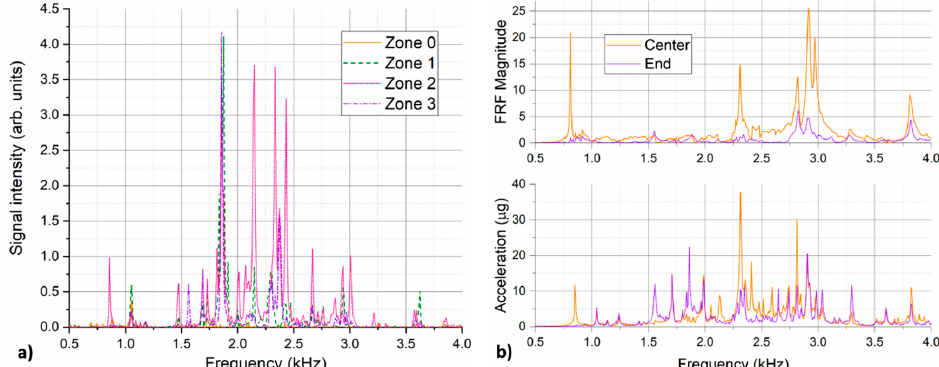
Figure 7. ( a ) Overall DAS signal spectra in different pipe zones for 1 mm leak at 25 bars; ( b ) Comparison of accelerometer signals recorded in the pipe zone 2 for 1 mm leak at 25 bars (bottom) and pipe frequency response function (FRF) determined by impact hammer test (top).